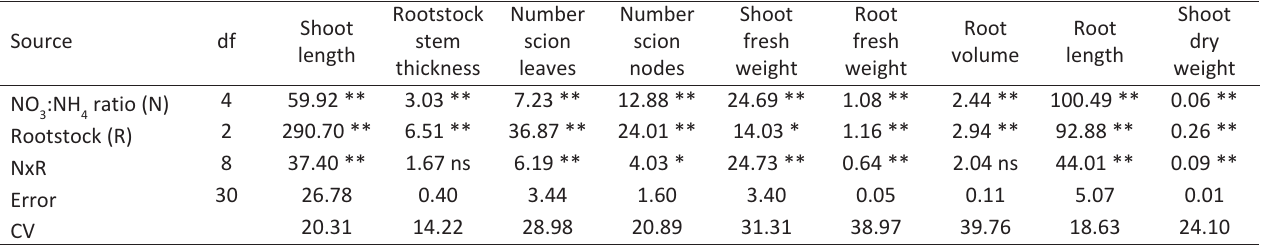
Table 2 ­ Analysis of variance effect of NO